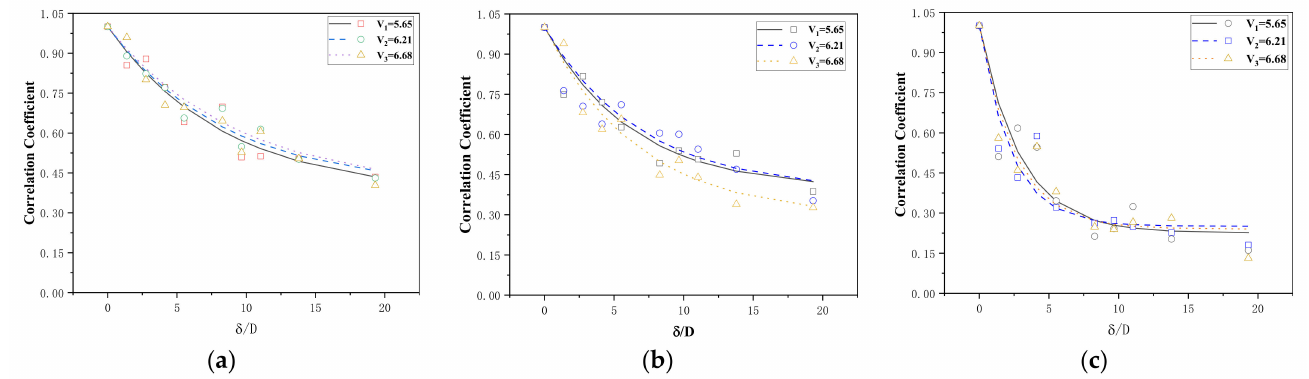
Figure 11. Spanwise correlation of aerodynamic coefficients in the vibrational state. ( a ) Spanwise correlation of lift coefficient; ( b ) Spanwise correlation of torque coefficient; ( c ) Spanwise correlation of resistance coefficient.